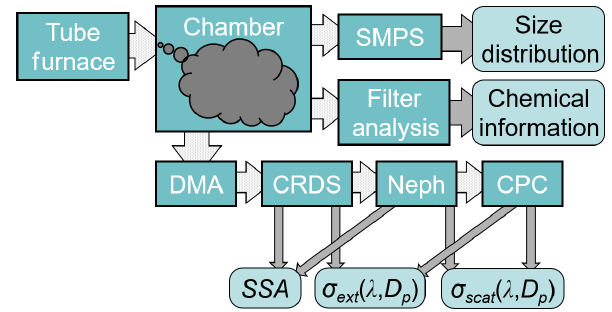
Figure 2. Scheme and flowchart for optical property